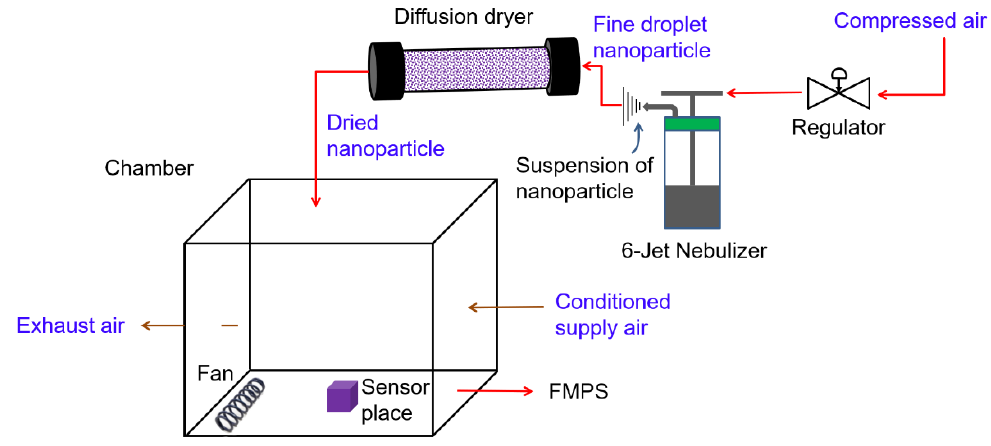
Figure 8. Schematic of the nanoparticle-generation setup as a test chamber, involving a nebulizer, a di ff usion dryer, a fan, and a fast mobility particle sizer (FMPS).